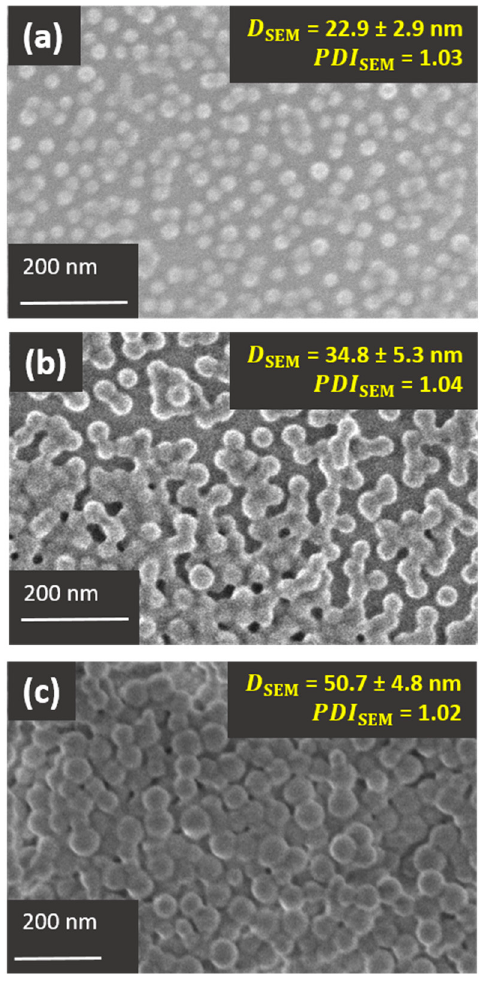
Figure 6. SEM images of ( a ) PHEA 85 – b –PS 130 , ( b ) PHEA 23 – b –PS 130 diblock copolymer